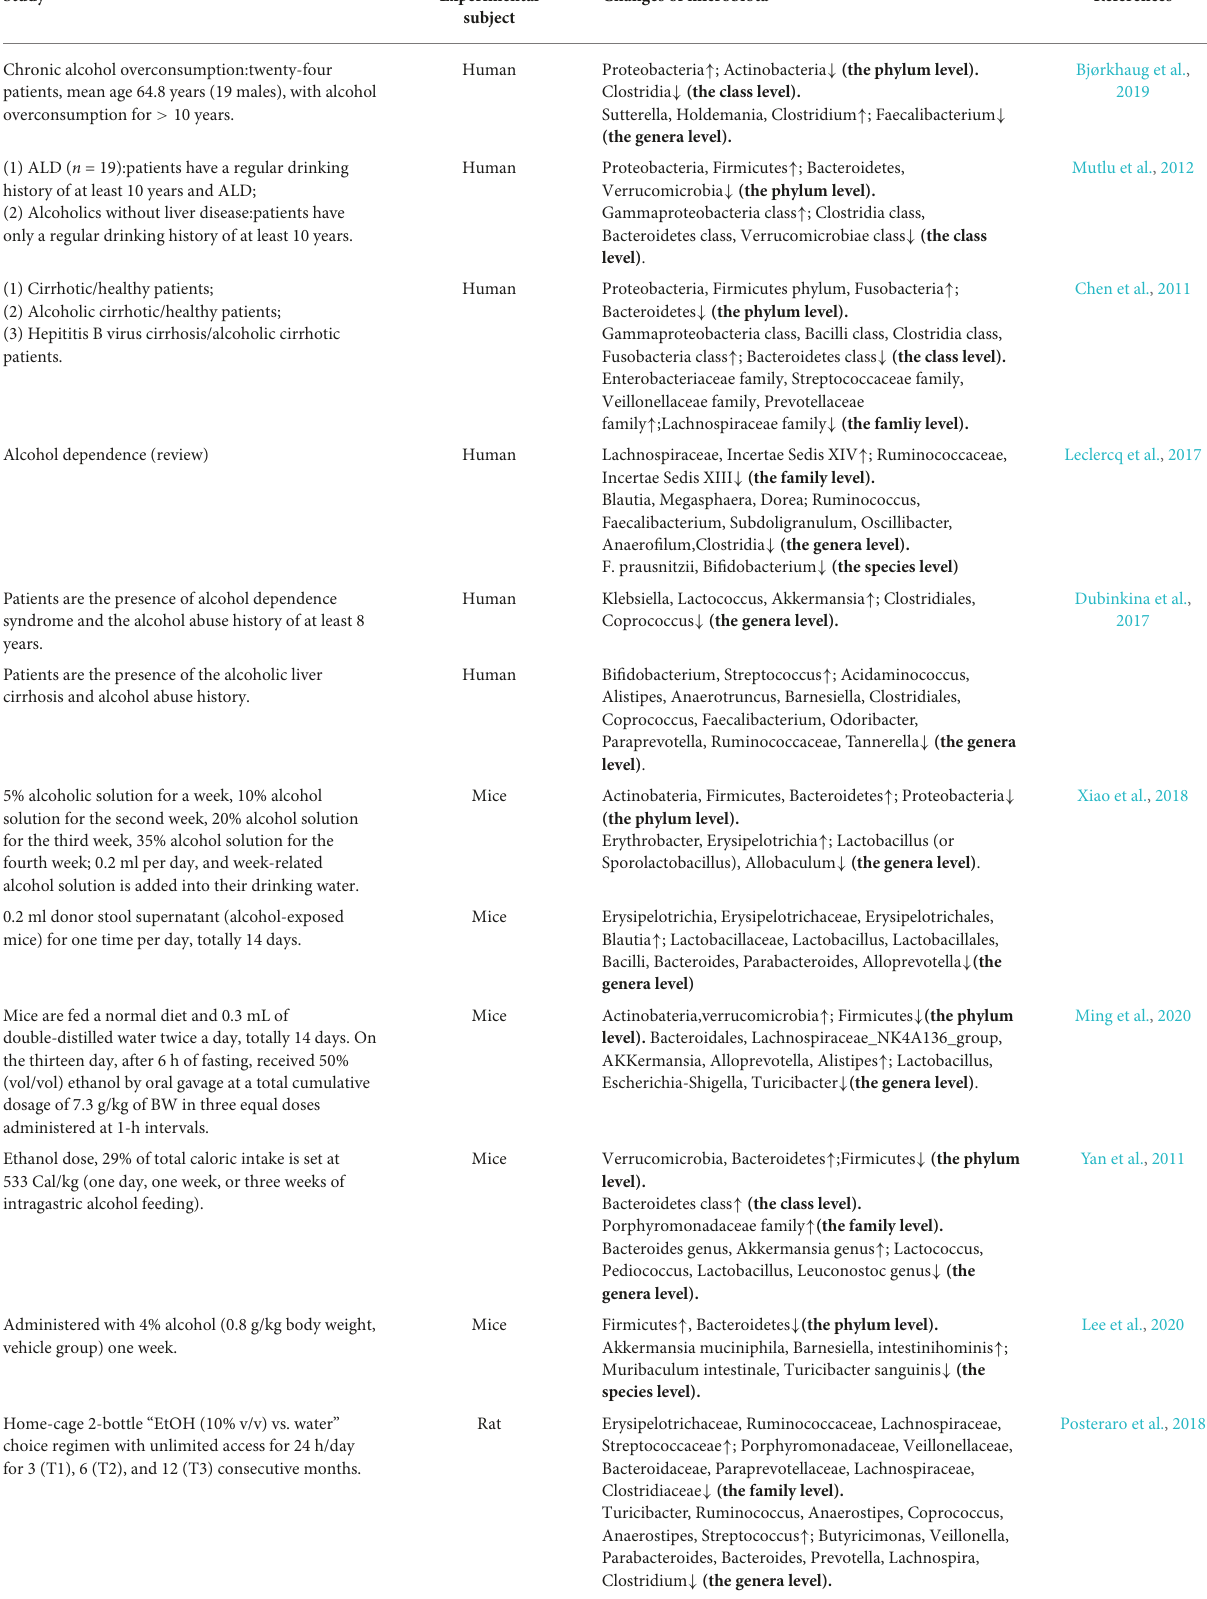
TABLE 1 The changes of gut microbiota composition caused by